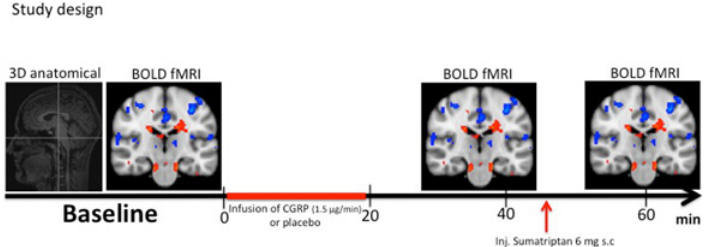
Fig 1. Study design: All variables were recorded at fixed time points throughout the study. The anatomical image was recorded at T -15 . BOLD-fMRI scan after noxious heat stimulation with the thermode was recorded at T -5 (baseline), at T 40 and T 60 (15 min after sumatriptan injection). Start of infusion was defined at T 0 . According to the randomization code CGRP (1.5 μ g/min) or placebo was infused over 20 min. Intervention with subcutaneous injection of sumatriptan was performed at T 45 . . Hemodynamic variables, adverse event and headache intensity on the verbal rating scale (VRS) was recorded at 0, 5, 10, 15, 25, 35, 45, 55 and 65